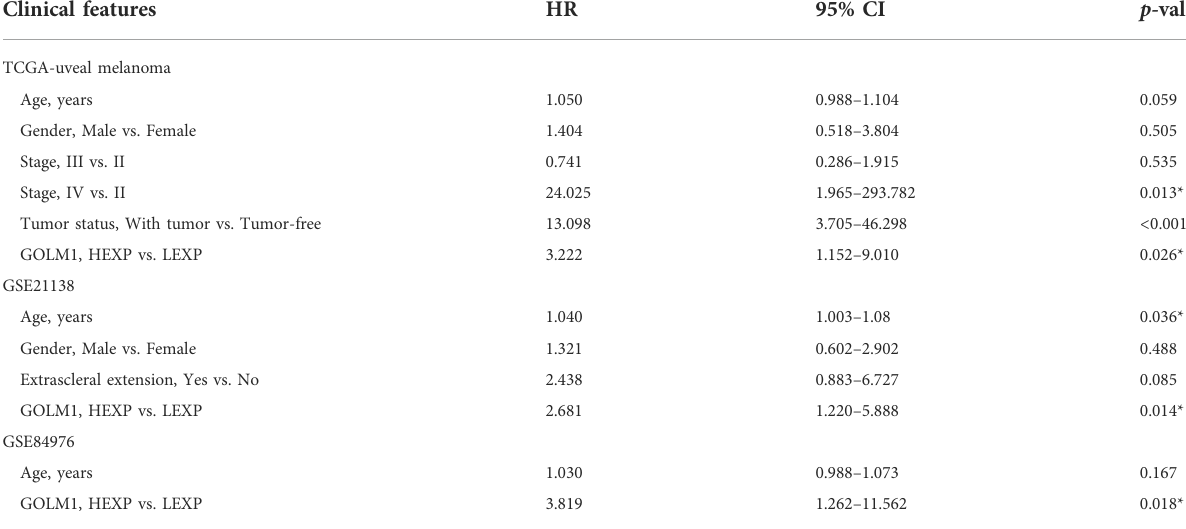
TABLE 3 Multiple cox regression analysis results in two uveal melanoma